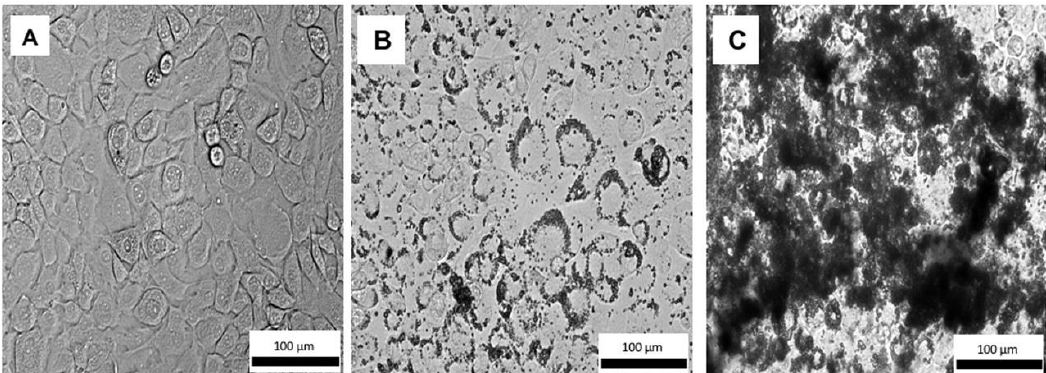
Figure 7. Brightfield images of live IMAC cells treated with ( A ) no particles; ( B ) 150 µ g / mL of PBSe-GSK3787 particles; ( C ) 1000 µ g / mL of PBSe-GSK3787 particles. The particles agglomerated and adhered to the outsides of the cell membranes. Cells treated with 150 µ g / mL of particles appeared healthy, whereas the cells were almost completely coated with particles at 1000 µ g / mL.